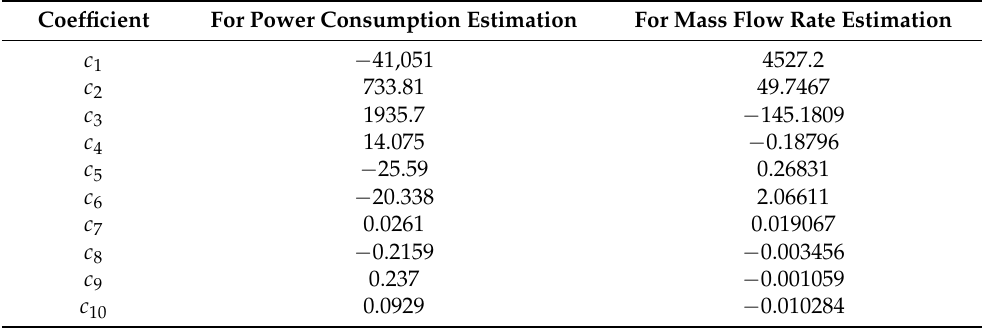
Table 1. Power consumption and mass flow rate coefficients given by Hanbell for the RC2-100G compressor model.